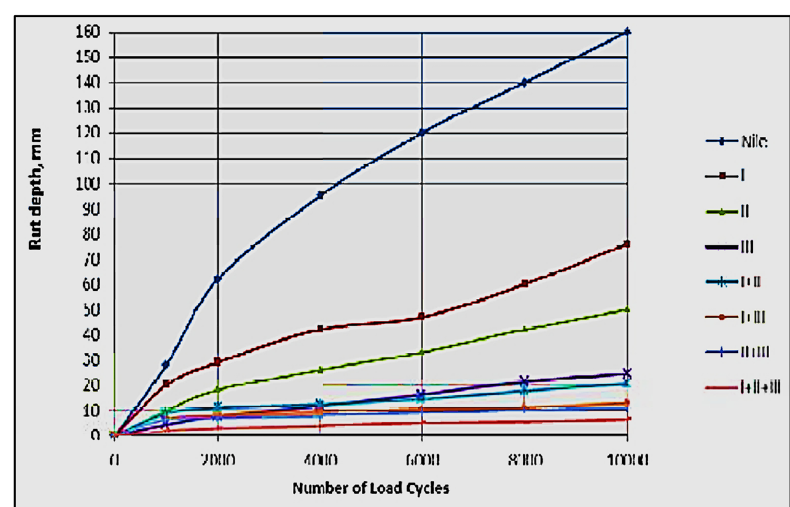
Figure 20: Rutting depth at di ff erent load cycles and